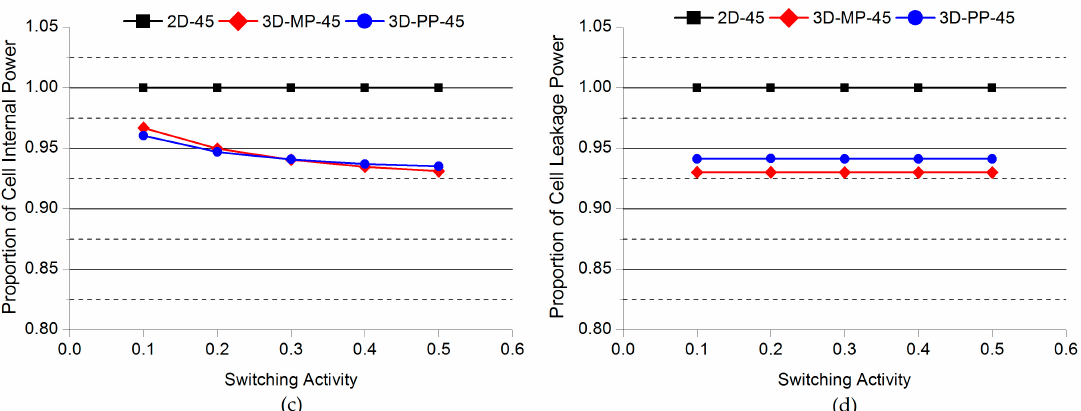
Figure 16. Comparisons of the normalized power of 2D and 3D ICs as a function of switching activity: ( a ) Total power; ( b ) net switching power; ( c ) cell internal power; ( d ) cell leakage power. Note that the power consumption of 2D-45 actually increases as the switching activity increases.